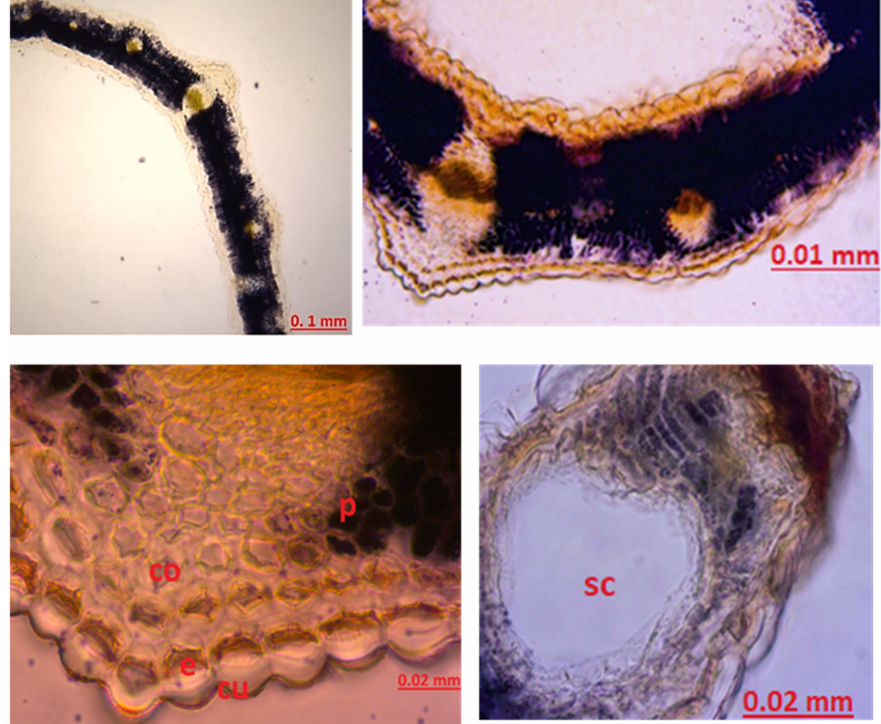
Figure 4. The leaf midrib transversal anatomy of Hypericum scabrum ; e: epidermis, p: parenchyma, sc: secretory canals, cu: cuticula, co: